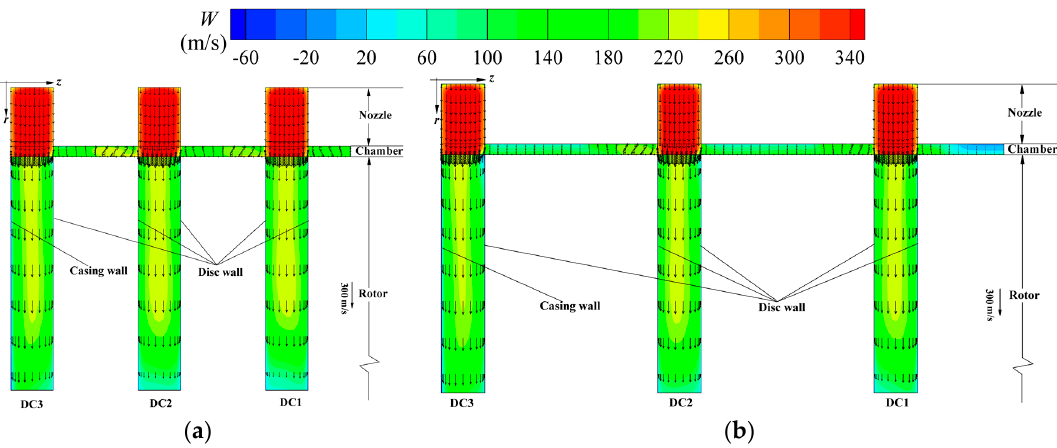
Figure 9. Contours of relative tangential velocity and vector distributions on radial cross-sections of 0° for the one-to-one Tesla turbine cases at 30,000 r/min: ( a ) Case 1-0.5; and ( b ) Case 2-0.5.